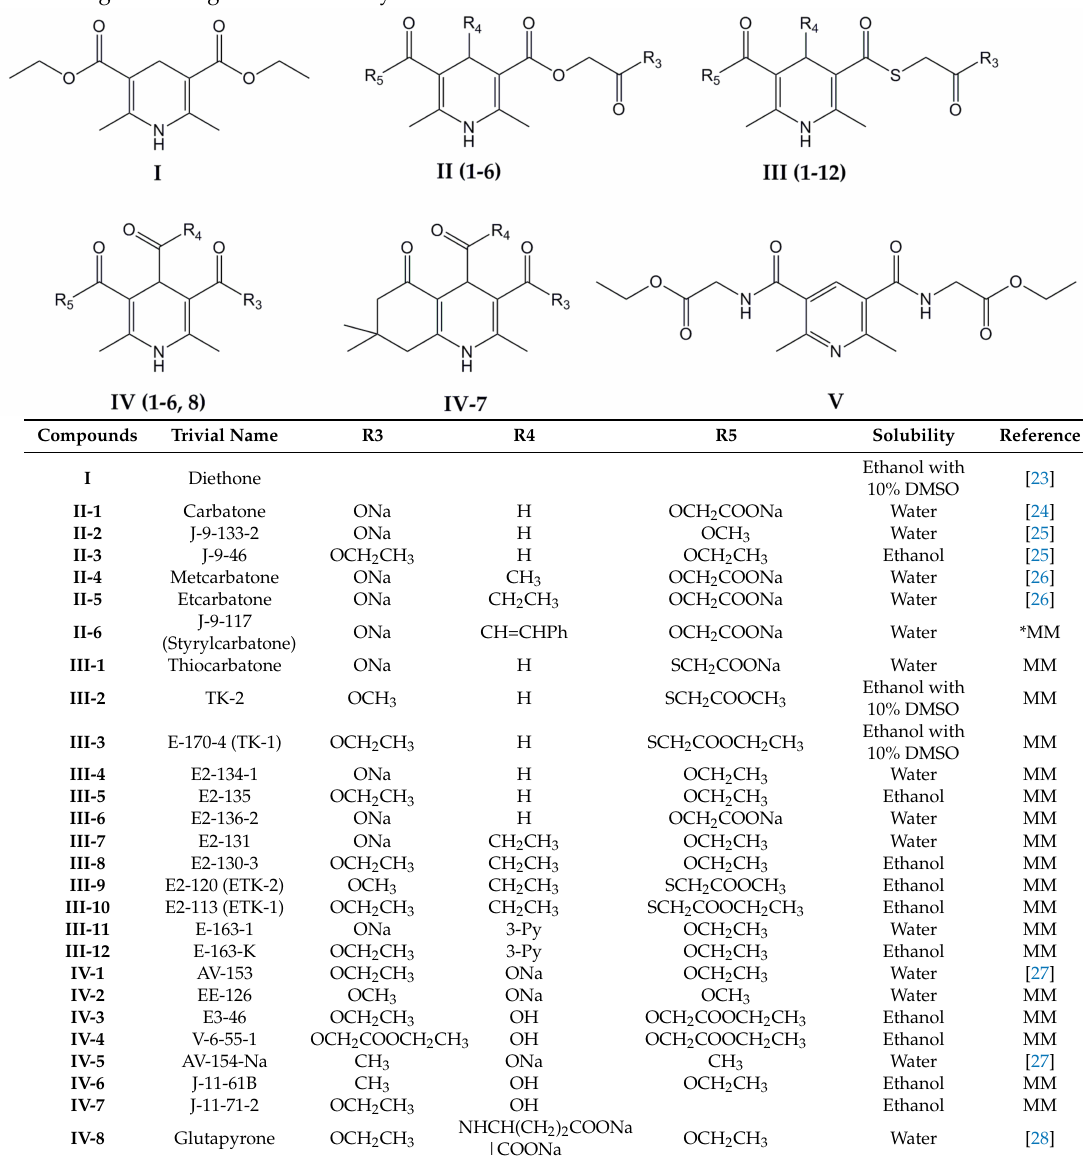
Table 1. Chemical structures and solubility of 27 1,4-dihydropyridine derivatives and one pyridine analogue investigated in this